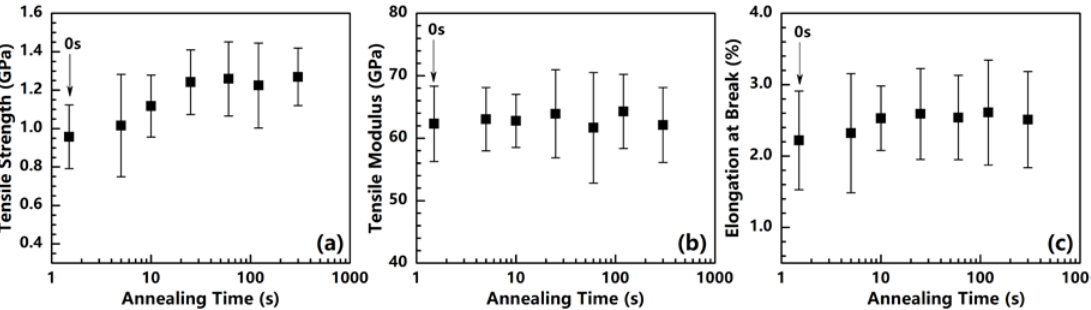
Figure 9. Tensile strength ( a ), Tensile modulus ( b ), and Elongation at break ( c ) of PI fibers annealed at 400 °C under different times.